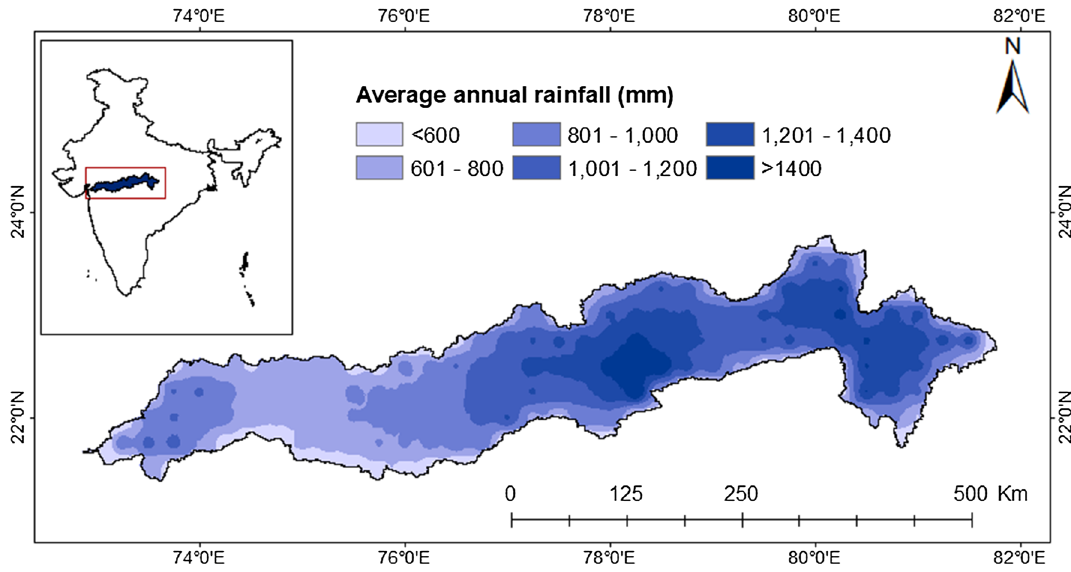
Fig. 1 Location of the study area (Narmada River Basin,